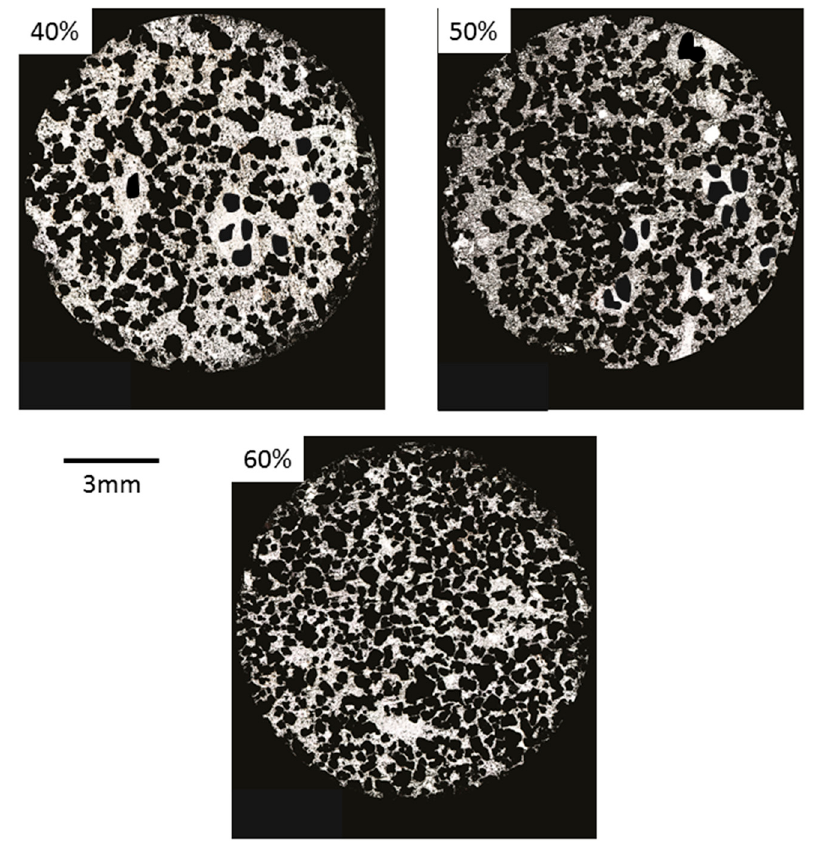
Figure 6. Optical images of 40, 50, and 60% porosity foams.